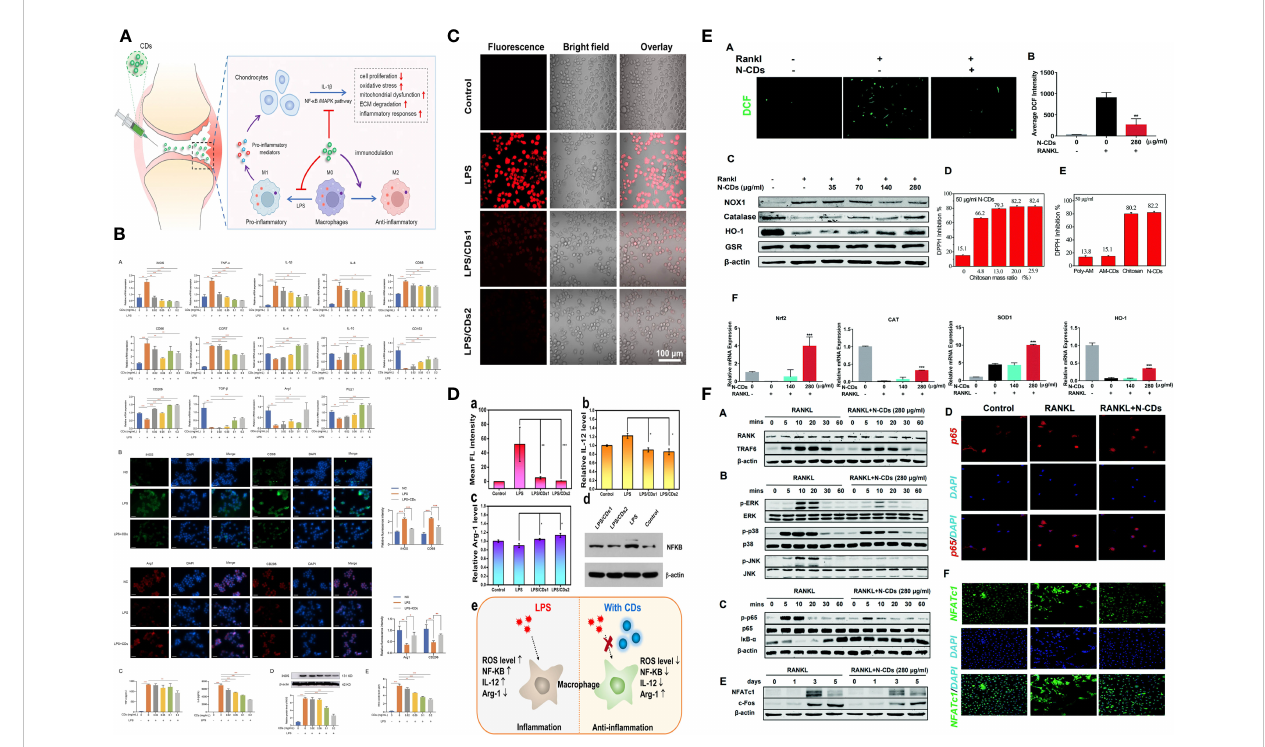
FIGURE 2 Regulation ROS and autophage with CDs. (A, B) CDs orchestrated macrophage repolarization in vitro and indicating the immunomodulatory mechanism of CDs mediated OA therapy. (C, D) CDs with radical-scavenging activity in alleviating the LPS-induced in fl ammation in macrophages. (E, F) N-CDs downregulated ROS with suppressed ROS downsteam signaling pathway.